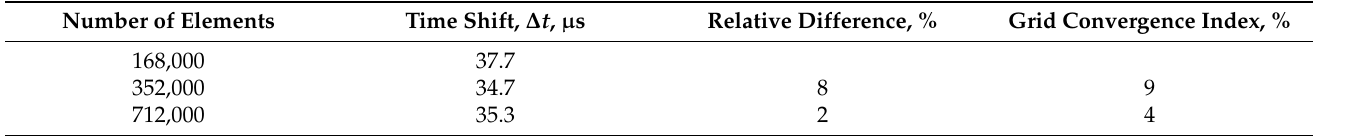
Figure 5. A typical change of the calculated tube position at sensors location and time shift depending on time (1 m/s, Case D). Table 2. Space discretization study for 8 m/s flow.